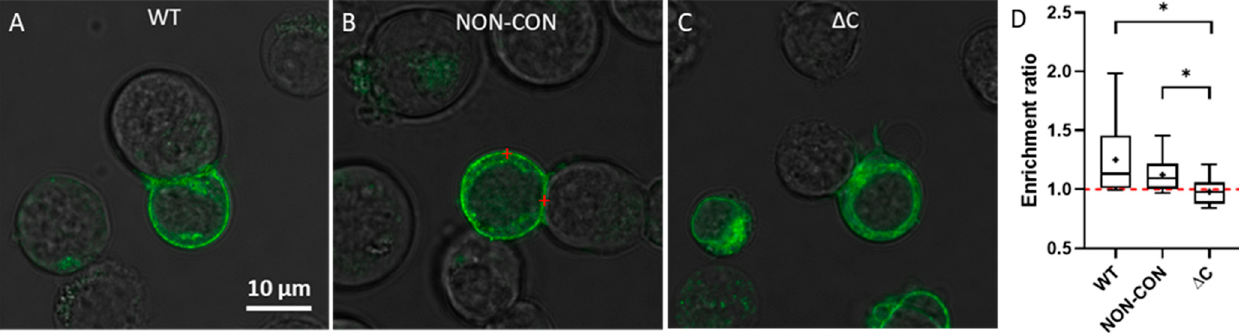
Figure 3. Transmission and fluorescence microscopic images of immunological synapses formed between a Raji B and Jurkat T cells expressing different mGFP-Kv1.3 variants. The red marks illustrate points inside and outside the IS where FCS measurements were typically carried out. Different versions of Kv1.3 are displayed: WT ( A ), NON-CON ( B ), and ∆ C mutant ( C ). Panel ( D ) shows the extent of Kv1.3 enrichment at the IS according to Equation (3). The ratio of the average pixel intensity inside the IS and in the whole cell membrane was calculated from confocal images by using MATLAB (for details see Materials and Methods). * p < 0.05.